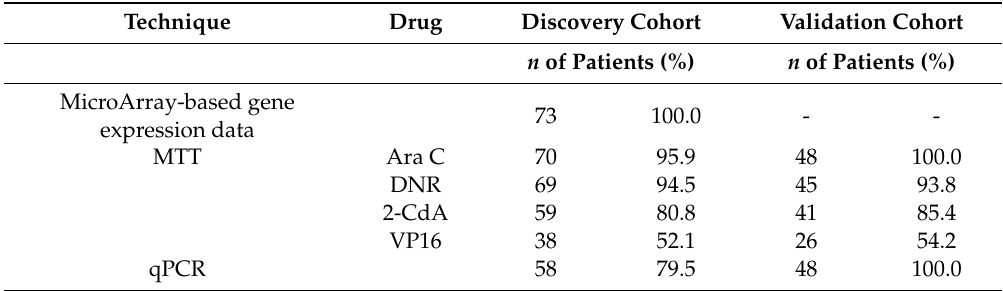
Table A5. Summary of experimental test performed in the discovery and validation cohort. MicroArray data were available for all patients in the discovery cohort. Ex vivo drug response MTT data were available for a selection of patients. qPCR data were available for all patients in the validation